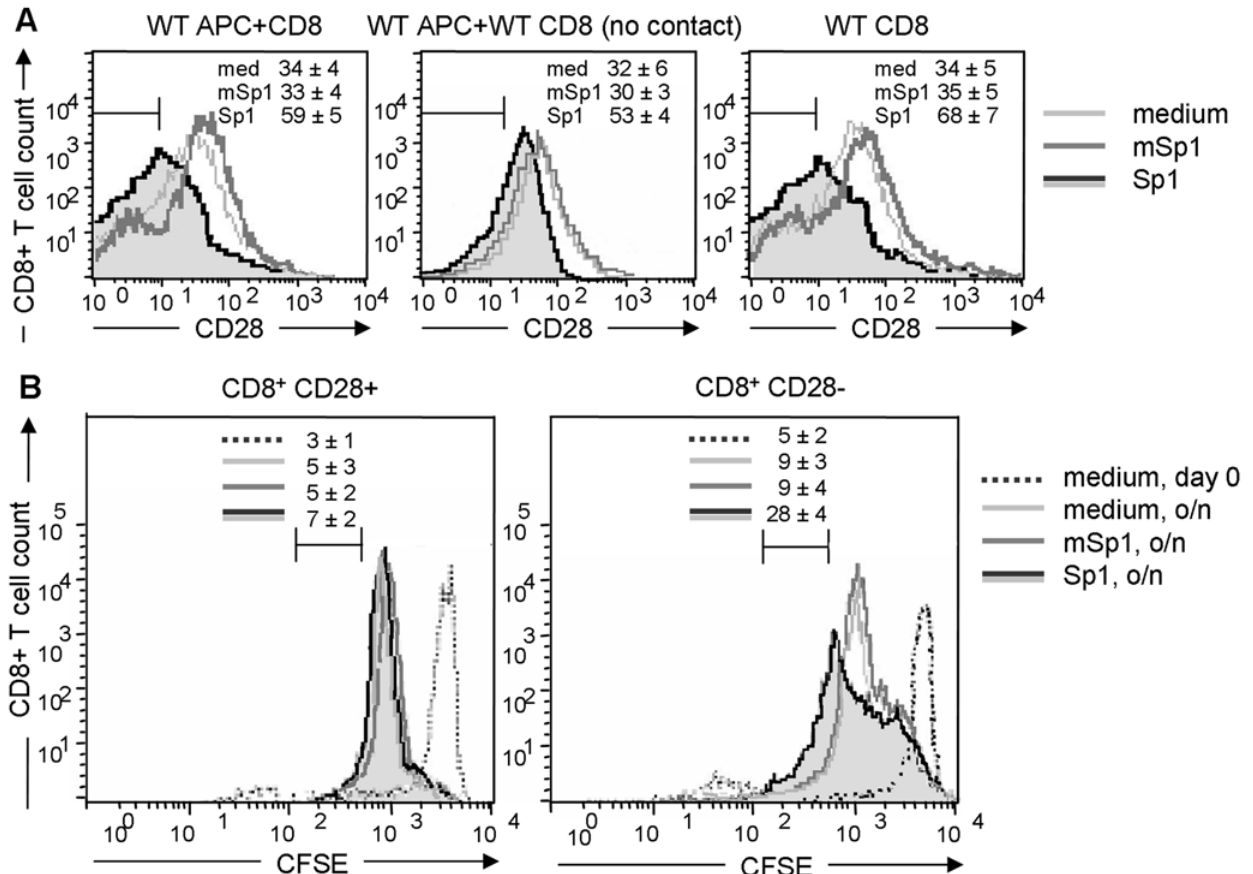
Figure 4. Sp1 induces CD8 + CD28 2 T lymphocytes invitro . A. Total spleen cells from C57BL/6 WT mice, purified CD8 + T cells from WT mice separated by a transwell from WT spleen cells to prevent direct contact, and purified CD8 + T cells alone were treated for 16 h in vitro with Sp1 (100 m g/ml), mSp1 (100 m g/ml), or medium alone (left panel). Cells were stained for CD8 and CD28 surface expression and prepared for flow cytometry. The figure shows one representative histogram out of three assays performed with cells from 5 animals each. Percentages 6 SD of the respective CD8 + CD28 2 cells are given in the upper right corner. B. CFSE-labeled CD8 + T cells were analyzed immediately after CFSE-labeling (medium, day 0), or incubated with Sp1, mSp1 (100 m g/ml, respectively), and medium overnight (o/n) and then analyzed for their proliferation capacity by flow cytometry. The figure shows one representative result out of three experiments performed independently with cells from 3 mice. The numbers above the marker in the histogram provides the percentage 6 SD of T cells undergoing division for more than three generations, respectively.